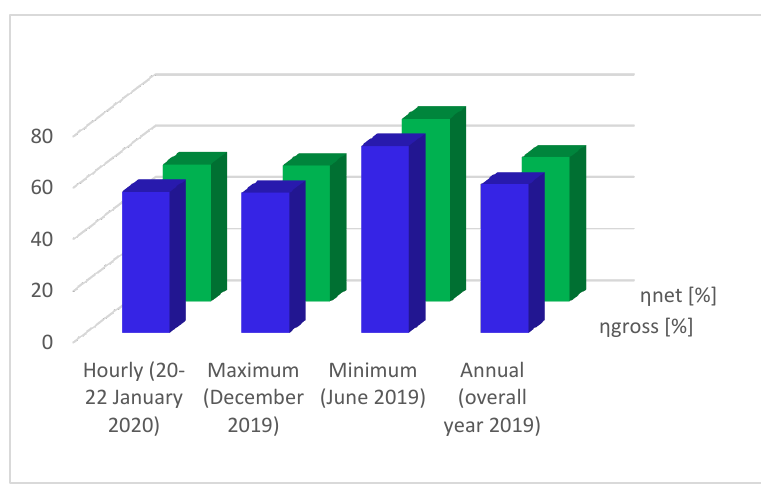
Figure 13. Energy performance indicators for HSGWPE.